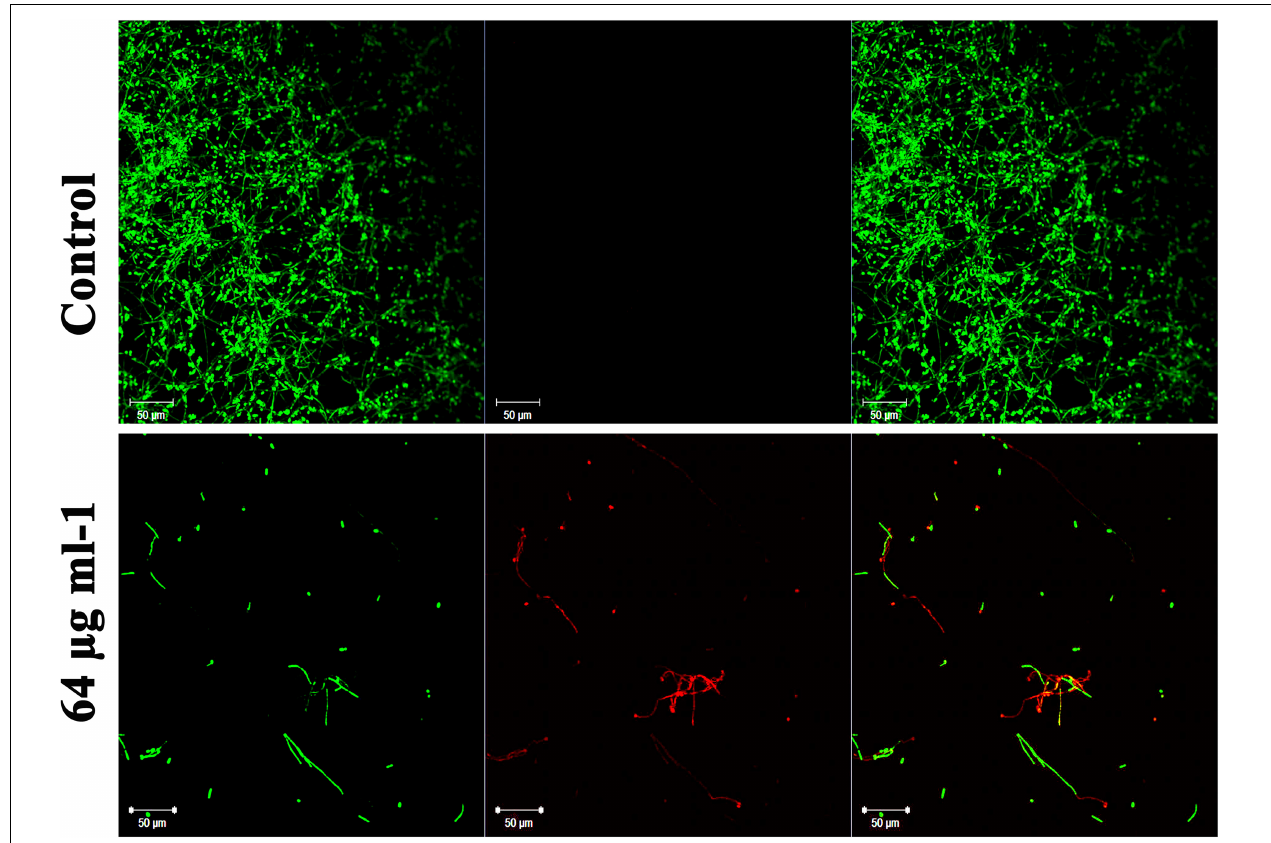
FIGURE 7 | Influence of piperine on disruption of preformed mature biofilm of C. albicans. Piperine effectively dislodged biofilm architecture of C. albicans at 64 µ g mL − 1 concentration (2 × BIC), leaving behind few hyphal